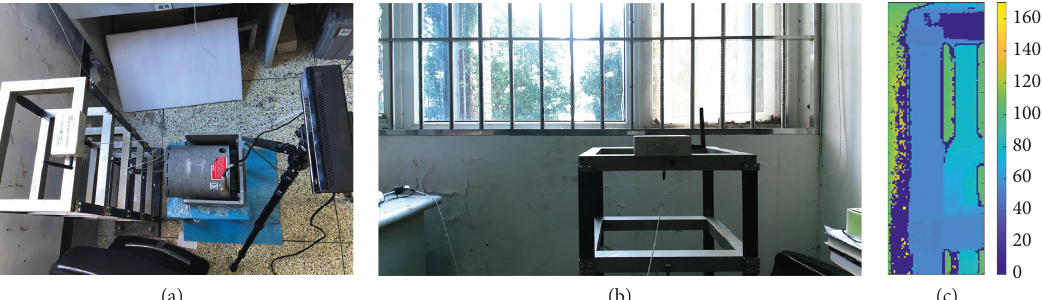
Figure 5: Verification test experimental setup. (a) Modular steel structure, Dynamics MODAL 50 exciter. (b) Field of view (FOV) of Kinect in the RGB image. (c) ROI raw depth information visualization.